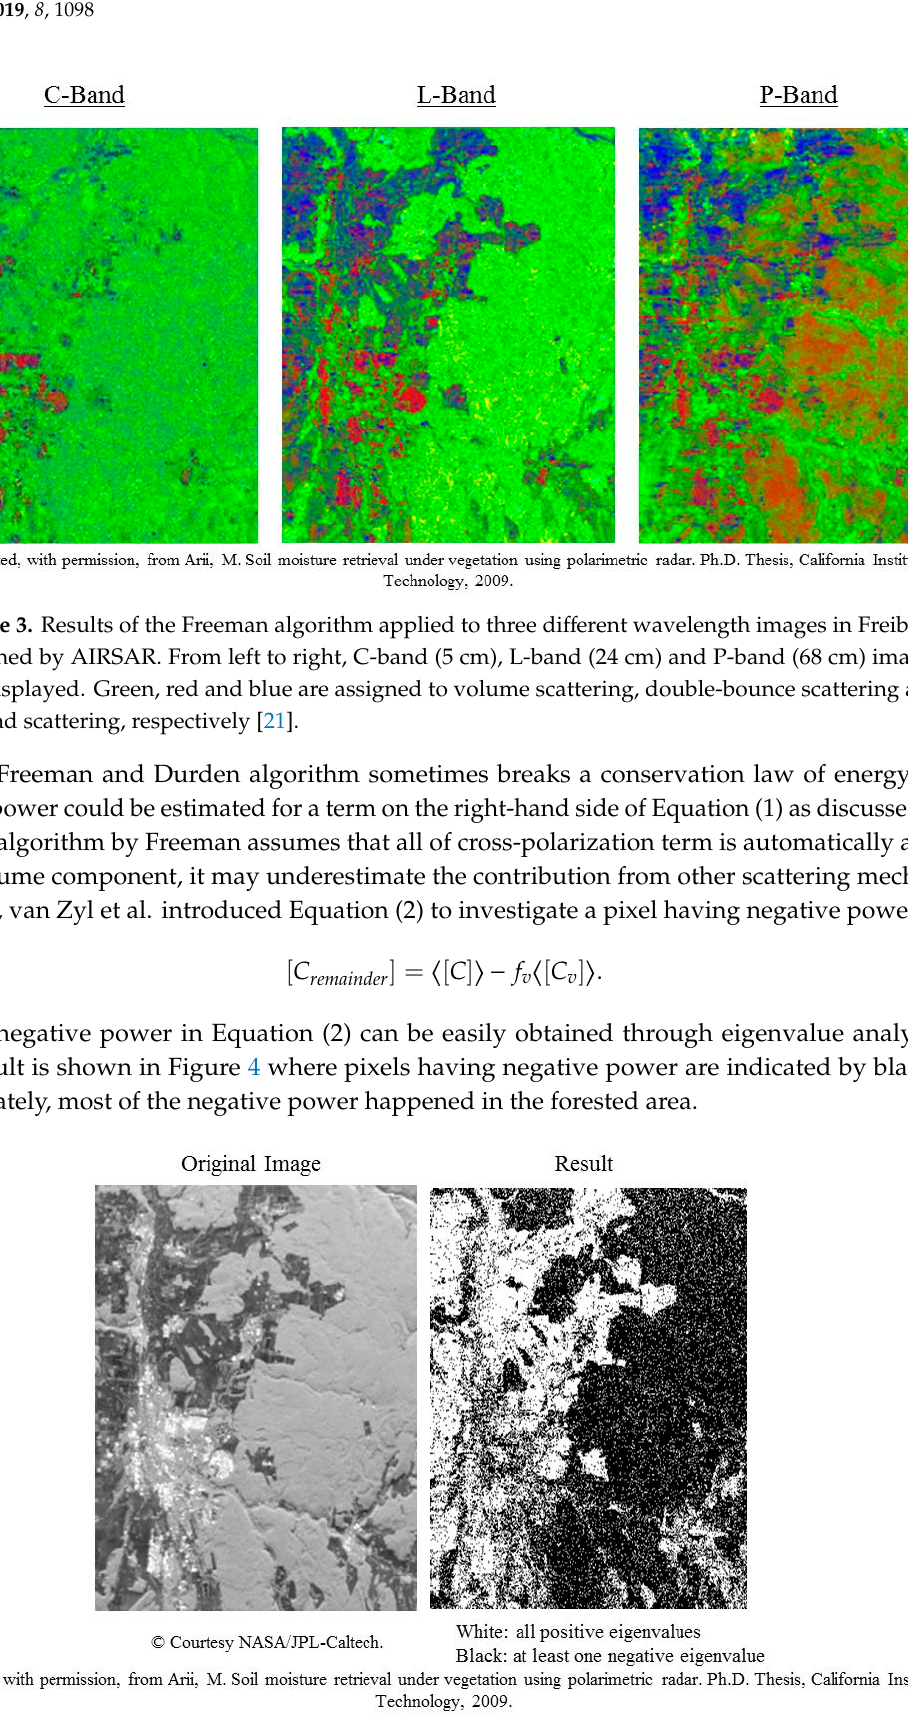
Figure 4. Pixels with negative eigenvalue are displayed using the L-band Black Forest image. The left image is the total power image at L-band, and the right image is the result of the validation test [21].